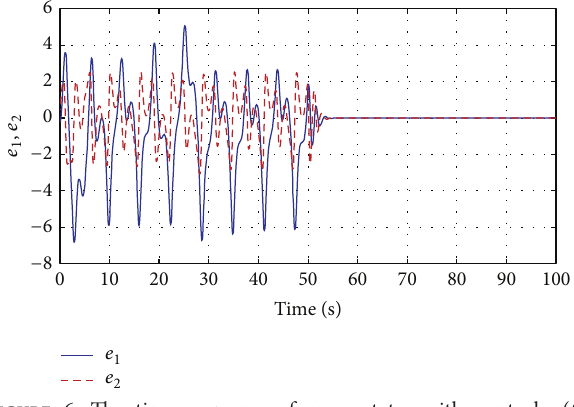
Figure 6: The time response of error states with control 𝑢(𝑡) activated at 𝑡 = 50 sec.